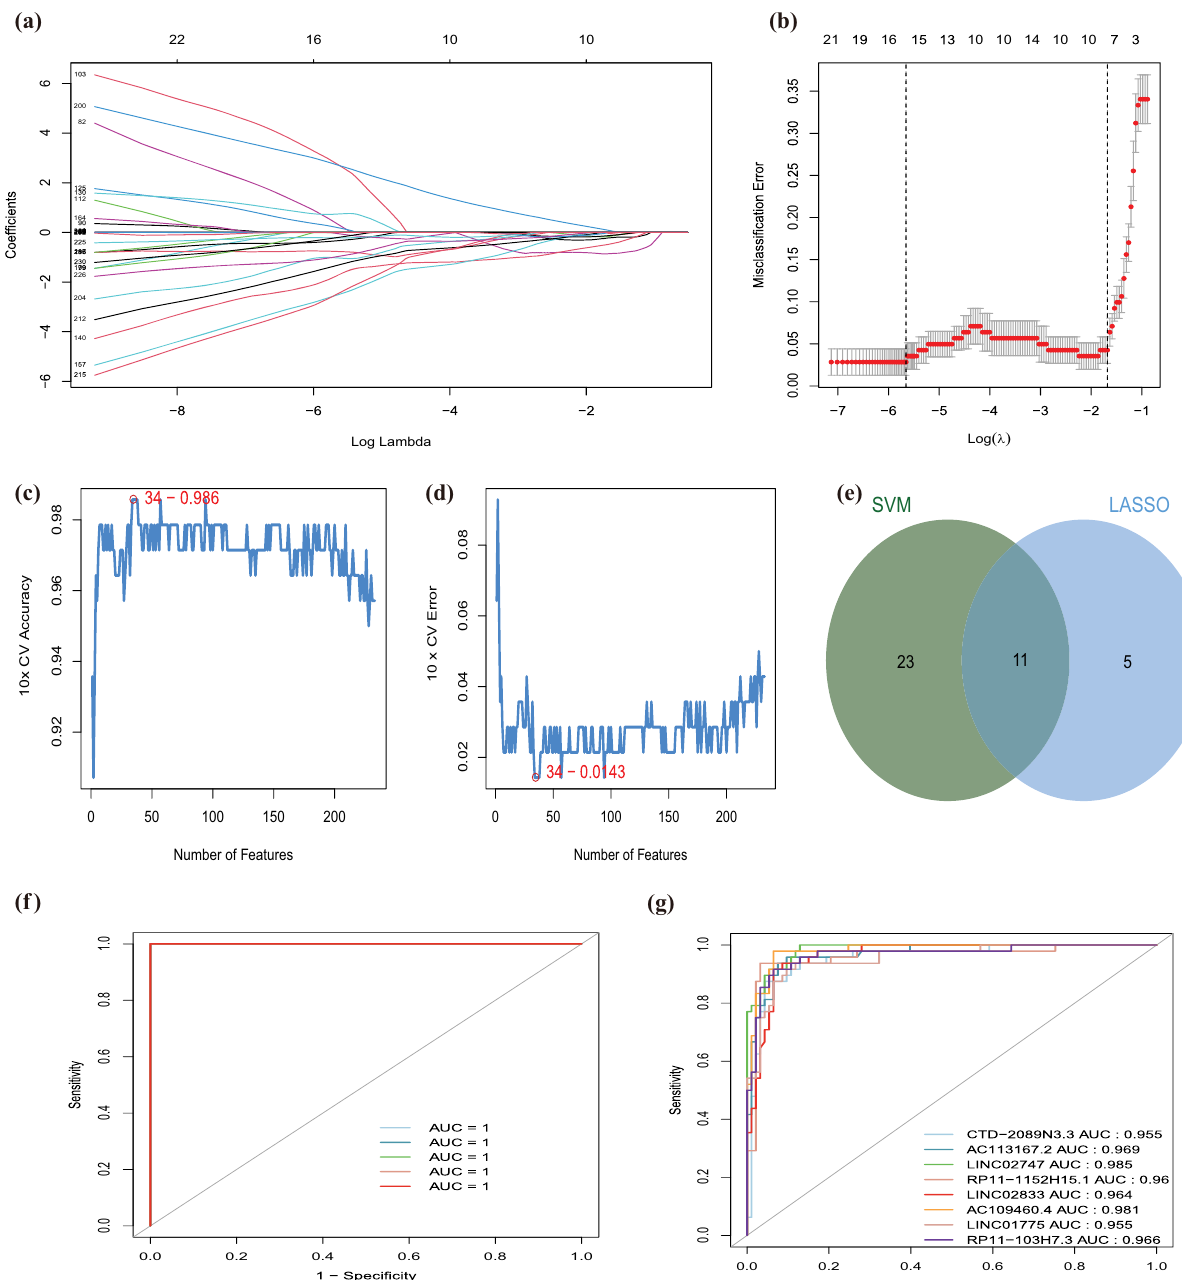
Figure 3: EMT - related lncRNAs diagnostic signature for CAD. ( a ) LASSO coe ffi cient pro fi les of the 16 EMT - related lncRNAs selected by the optimal lambda. ( b ) The diagnostic signature selection of optimal parameter ( lambda ) in LASSO model. ( c and d ) Results of SVM - RFE algorithms: The point highlighted indicates the lowest error rate, and the corresponding EMT - related lncRNAs at this point are the best signature selected by SVM - RFE. ( e ) Venn diagram of overlap EMT - related lncRNAs selected by LASSO and SVM - RFE algorithms. ( f ) The ROC curve of predicted outcomes of eight EMT - related lncRNAs diagnostic signature by a logistic regression model. ( g ) ROC analysis results for eight EMT - related lncRNAs in